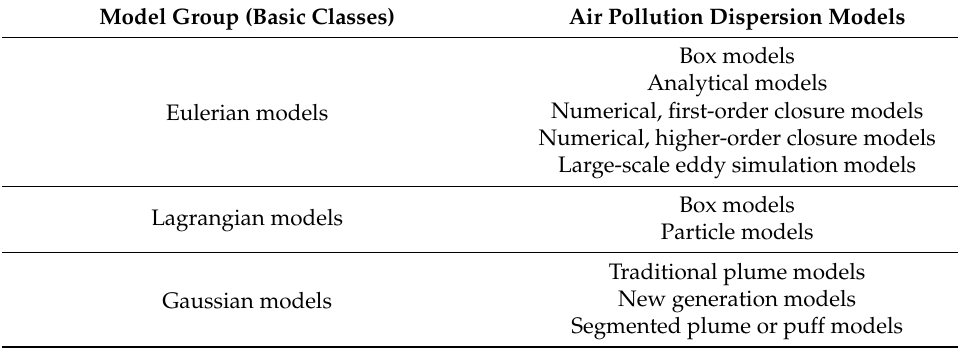
Table 1. Classification of air pollution dispersion models based on mathematical criteria [14].